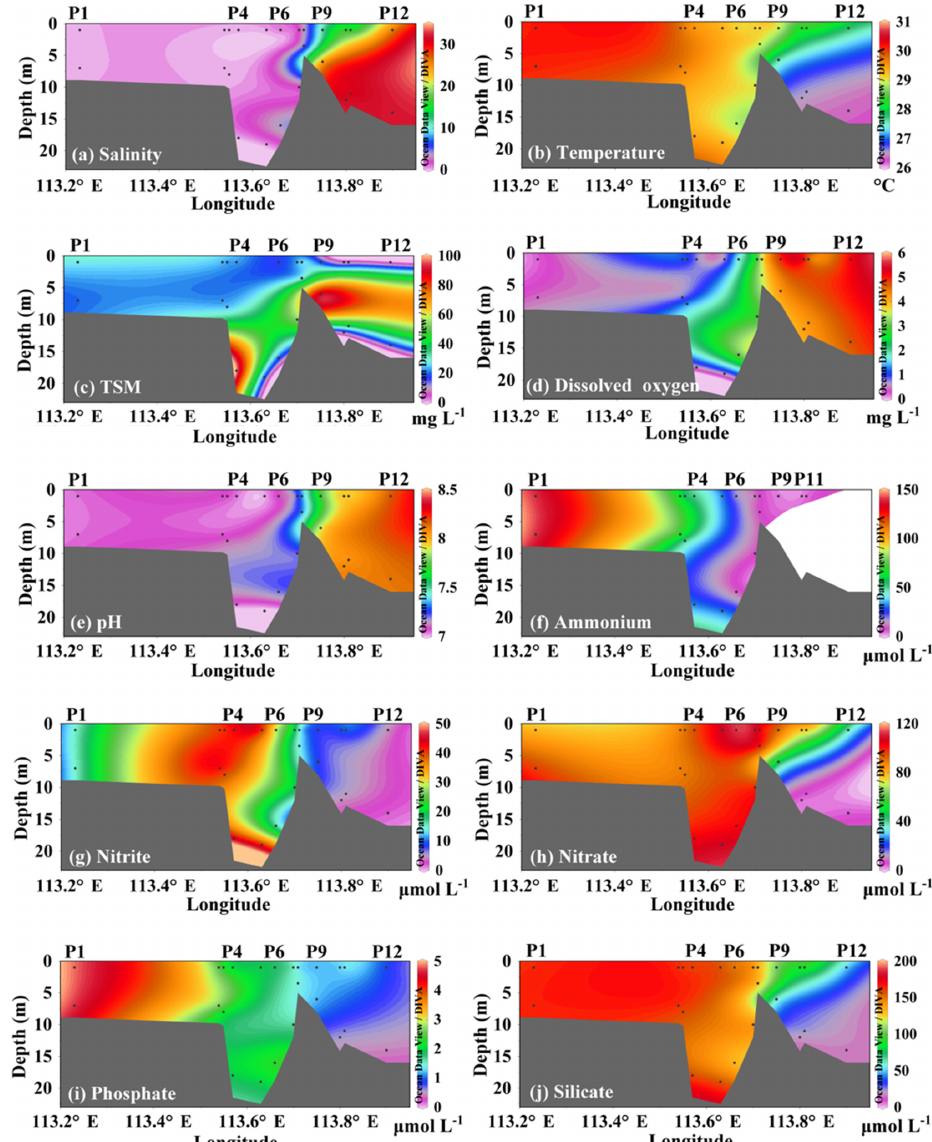
Figure 2. Distributions of biogeochemical factors along the PRE transect. (a) Salinity, (b) temperature, (c) TSM, (d) DO, (e) pH, (f) ammo- nium, (g) nitrite, (h) nitrate, (i) phosphate, and (j) silicate concentration. P1–12 indicate PRE sampling sites. Black dots indicate sampling